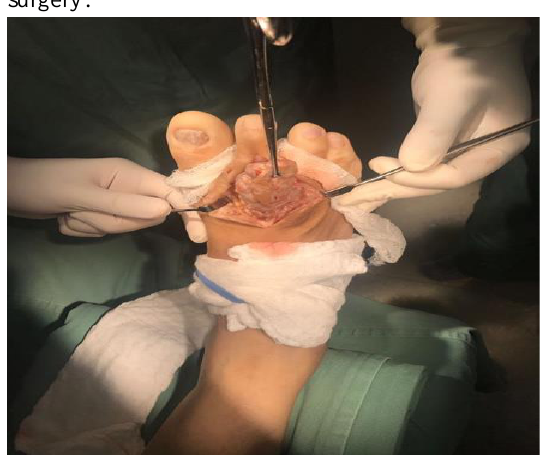
Figure 1. Hyalohyphomycosis being removed in surgery.